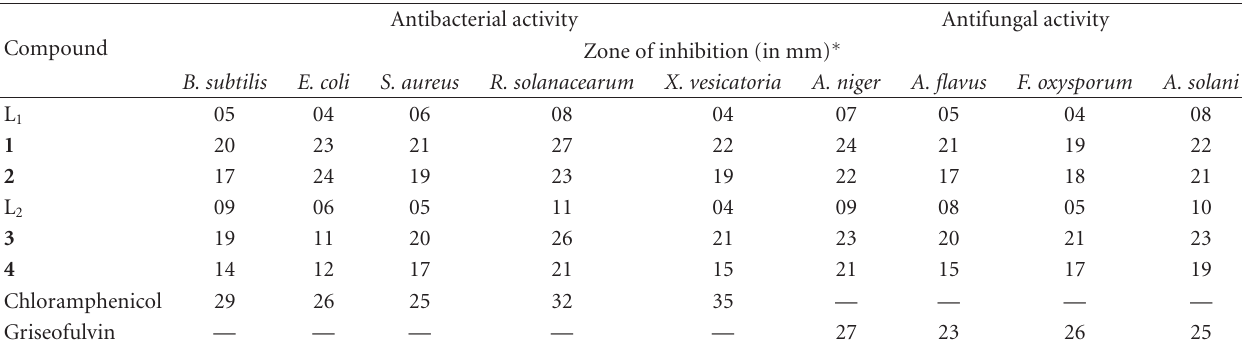
Table 4: Antimicrobial activity of Schi ff bases and their corresponding organotin(IV) complexes. Compound